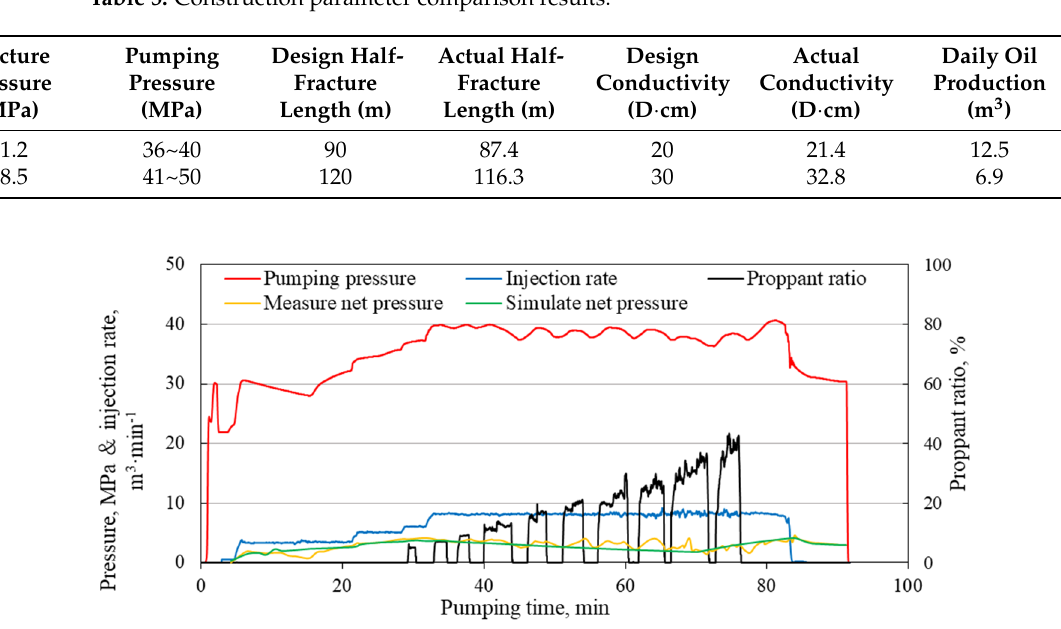
Figure 15. Perforation location optimization results. ① , ② and ③ represent three perforation posi- tions respectively.